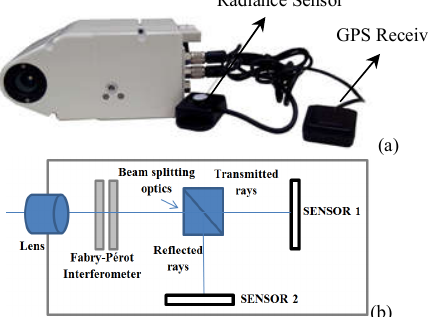
Figure 1. (a) Rikola hyperspectral camera with accessories and (b) Diagram showing internal components (Tommaselli et al., 2016).